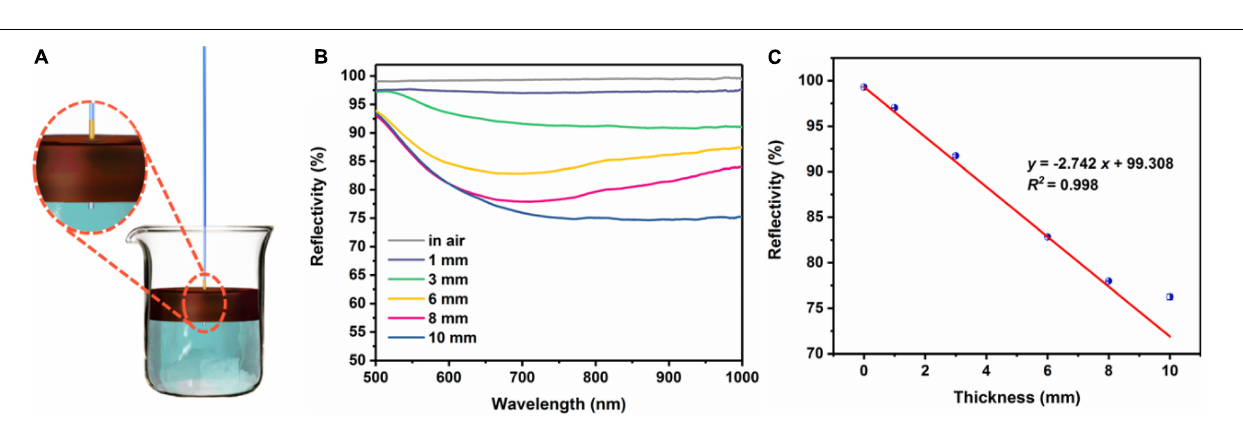
FIGURE 3 | (A) Schematic diagram of oil detection at the air-oil interface by FOSPR sensor (the bottom of sensing region remains at the bottom of the oil); (B) Reflectivity spectra of the electroless-plated optical fiber SPR sensors in air-oil interface with different oil spill thicknesses; and (C) Linear curve of reflectivity and height (this linear relationship is based on a wavelength of 700.6 nm).